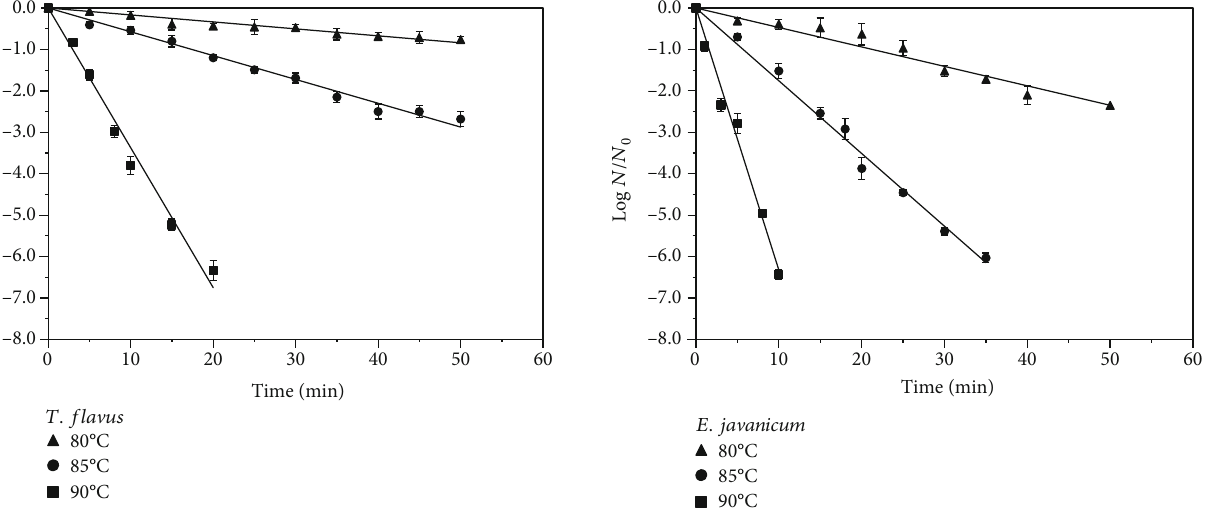
Figure 2: Heat inactivation of Eupenicillium javanicum ascospores